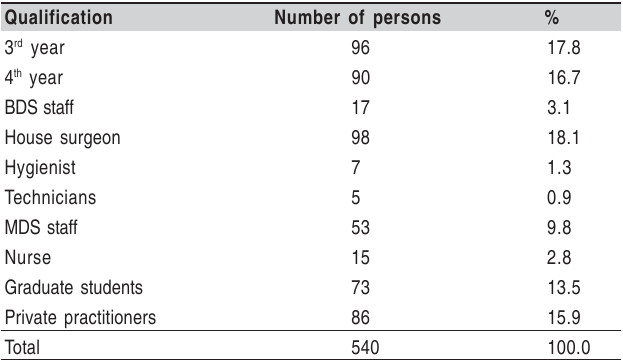
Table 1 - Number of persons in each category divided as per their